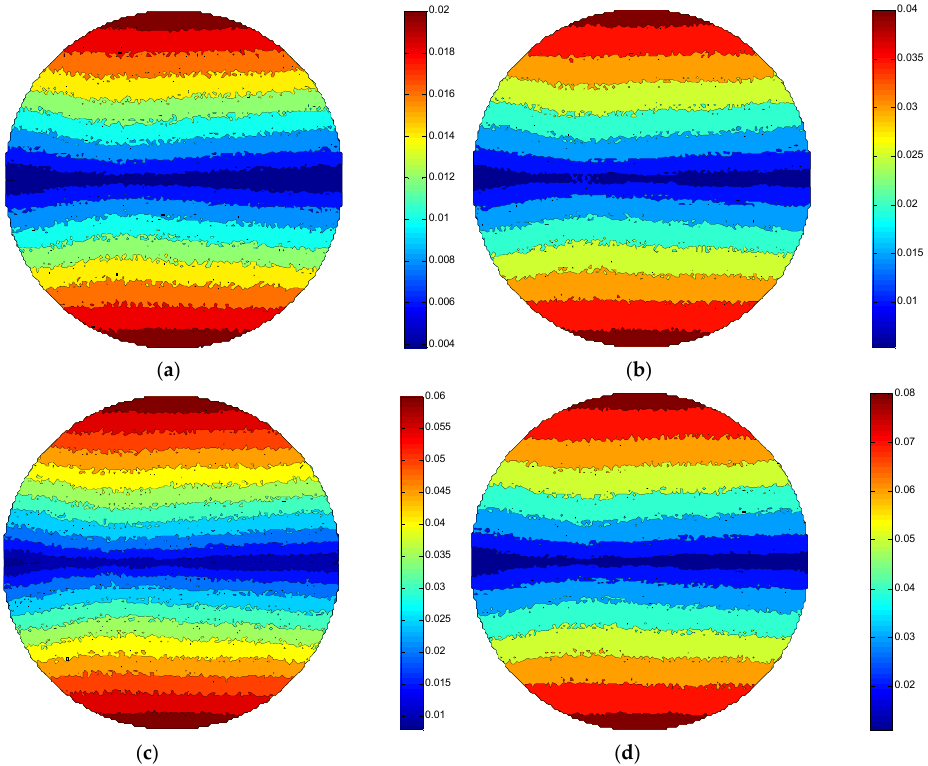
Figure 5. Distribution of MRR under different workpiece rotational speed conditions: ( a ) n = 150 rpm, ( b ) n = 300 rpm, ( c ) n = 450 rpm, ( d ) n = 600 rpm.